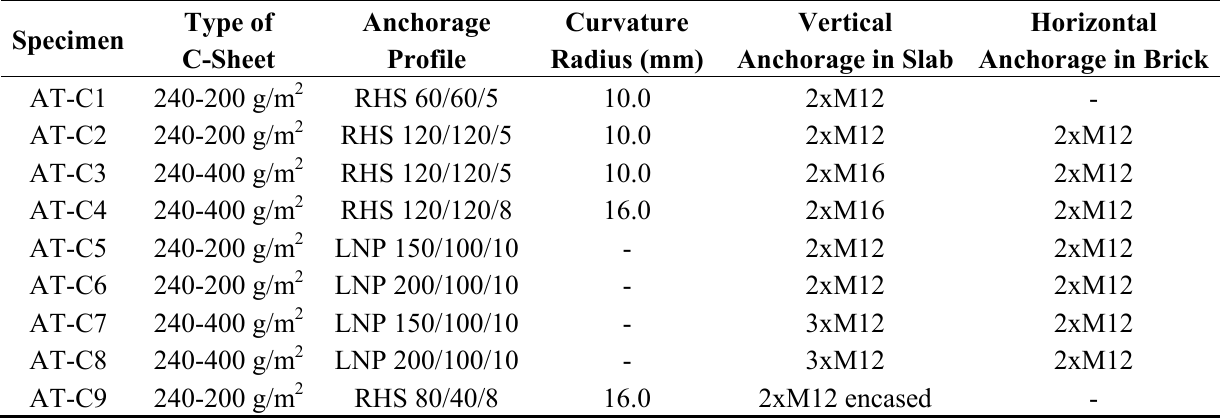
Table 9. Characteristics of Series